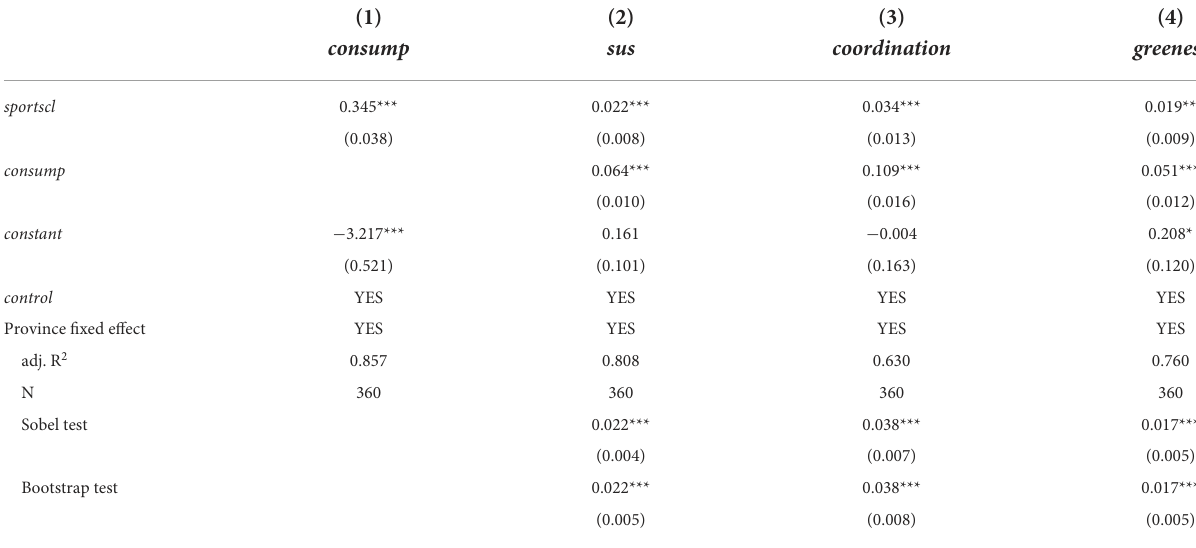
TABLE 8 The regression result of the mediating effect based on residents’ consumption levels.